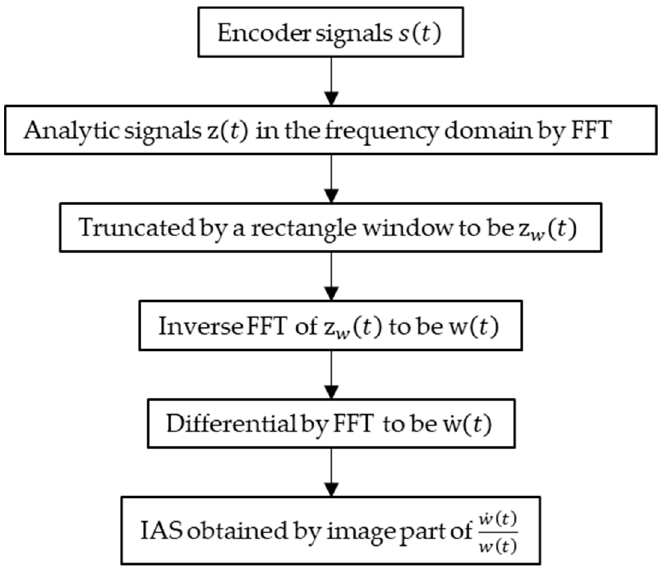
Figure 2. Flow chart of instantaneous angular speed (IAS) estimation by the frequency domain